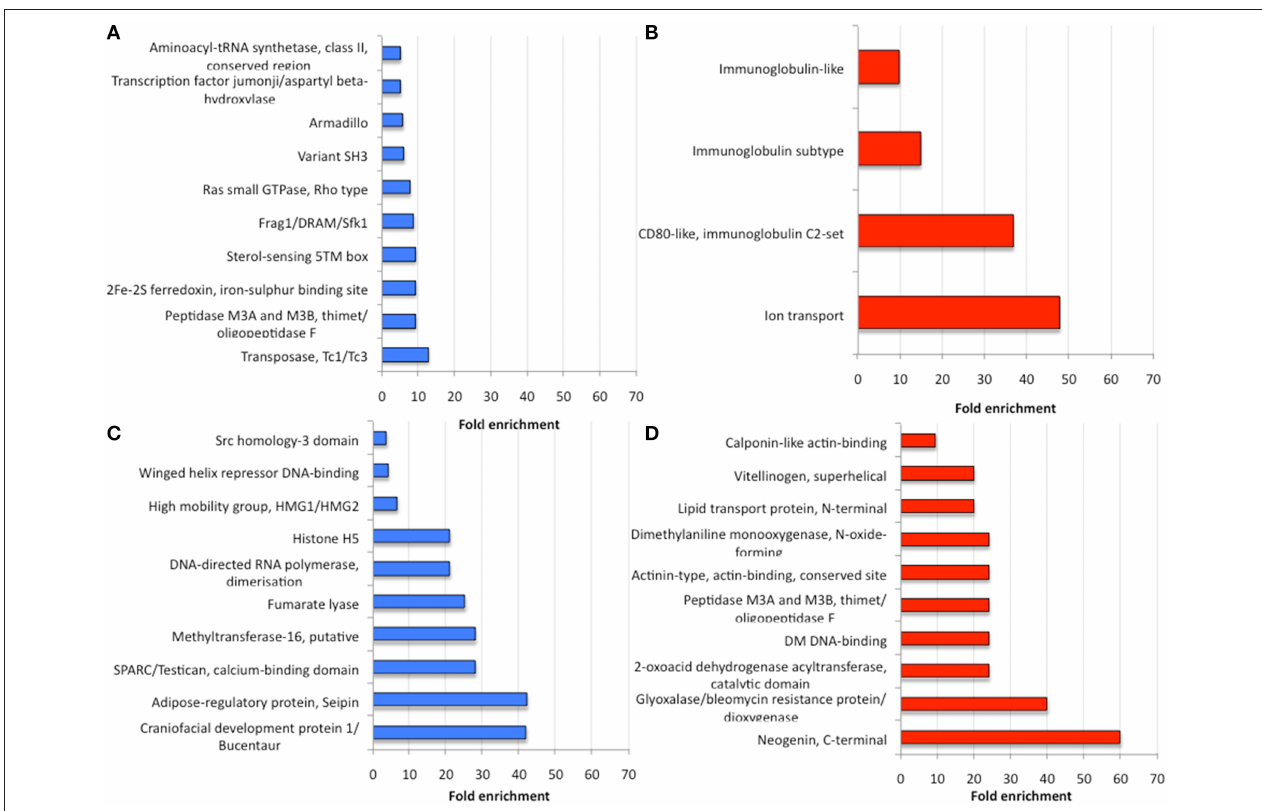
FIGURE 5 | Analysis of most differentially expressed genes in response to A. phagocytophilum infection of I. ricinus IRE/CTVM20 and I. scapularis ISE6 cells. (A) Proteins encoded by the 10 most upregulated genes in I. ricinus IRE/CTVM20 cells. (B) Proteins encoded by the 4 most upregulated genes in I. scapularis ISE6 cells. (C) Proteins encoded by the 10 most downregulated genes in I. ricinus IRE/CTVM20 cells. (D) Proteins encoded by the 10 most downregulated genes in I. scapularis ISE6 cells. The InterPro motifs obtained using DAVID were used to evaluate the fold enrichment of differentially expressed genes in the corresponding tick cell line ( p ≤ 0.05